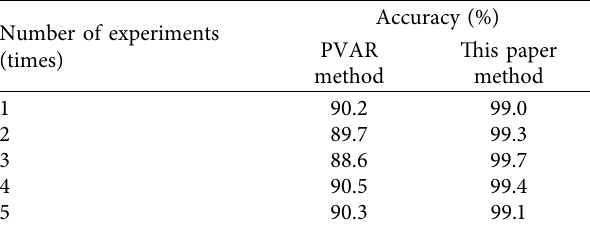
Table 2: Prediction accuracy analysis of different